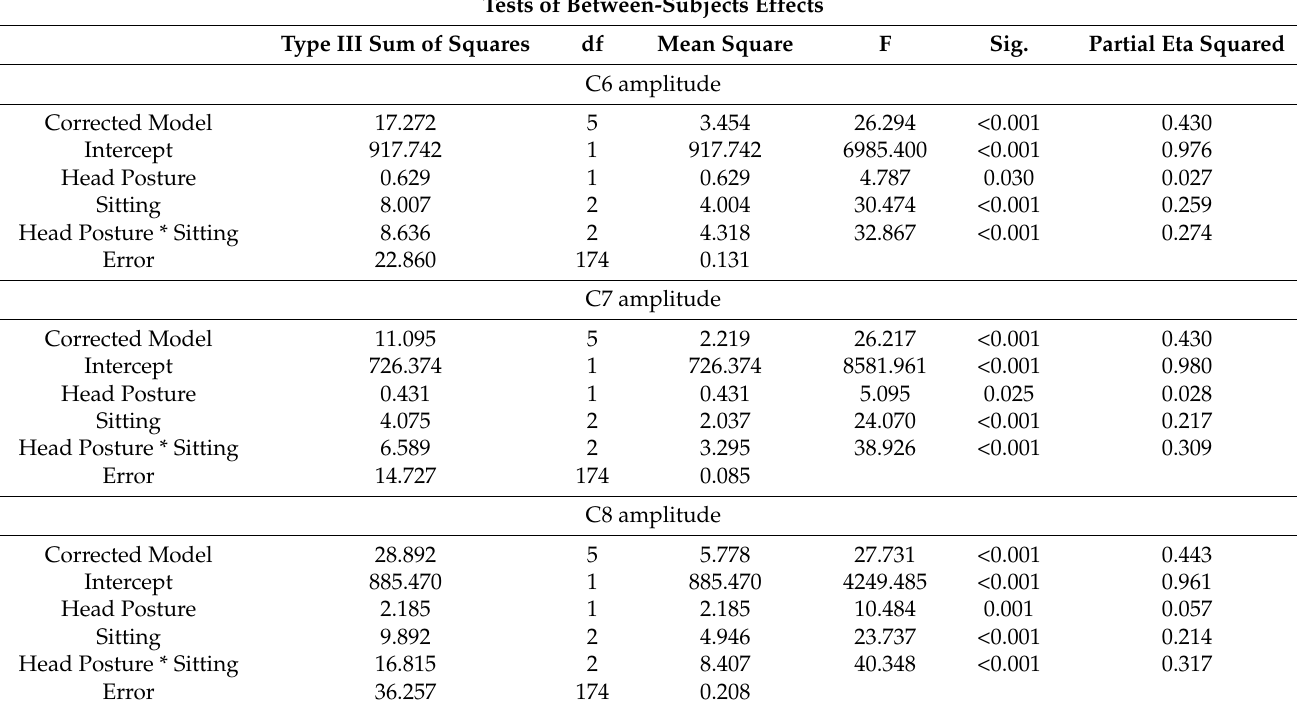
Table 3. Two-way analysis of variance